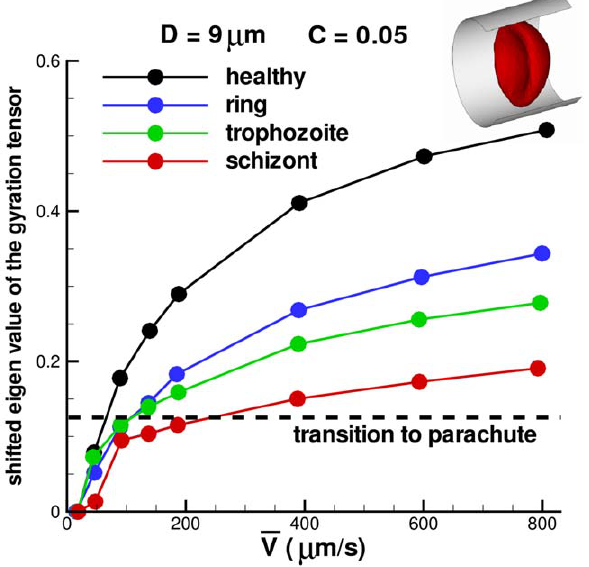
Figure 10. Viscosity of the infected blood in malaria for different parasitemia levels (percentage of infected RBCs with respect to the total number of cells in a unit volume) in comparison with experiments [ 21 ] . Infected blood is modeled as a suspension of healthy and Pf-RBCs at the schizont stage at T ~ 23 o C suspended in blood plasma. The shear moduli of Pf-RBCs for different stages are given in Table 1 and the bending stiffness is set to 2 : 4 | 10 { 19 J . The diamond symbol represents a simulation with adhesive interactions among RBCs.